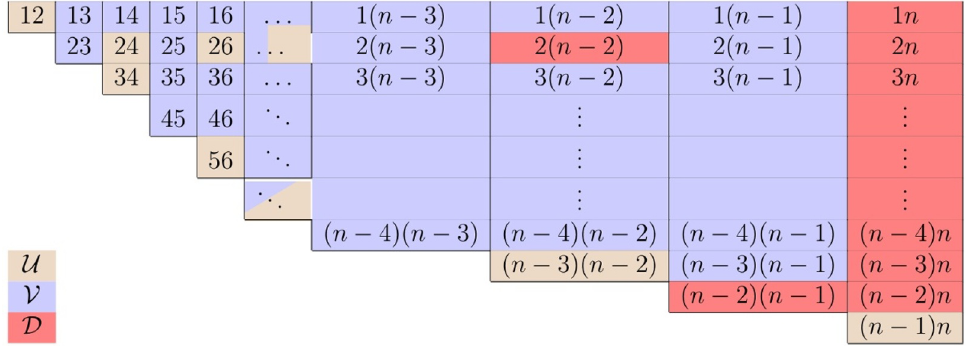
Figure 7. Color-coded matrix displaying the canonical choice of Mellin variable index subsets U OPE , V OPE and D OPE